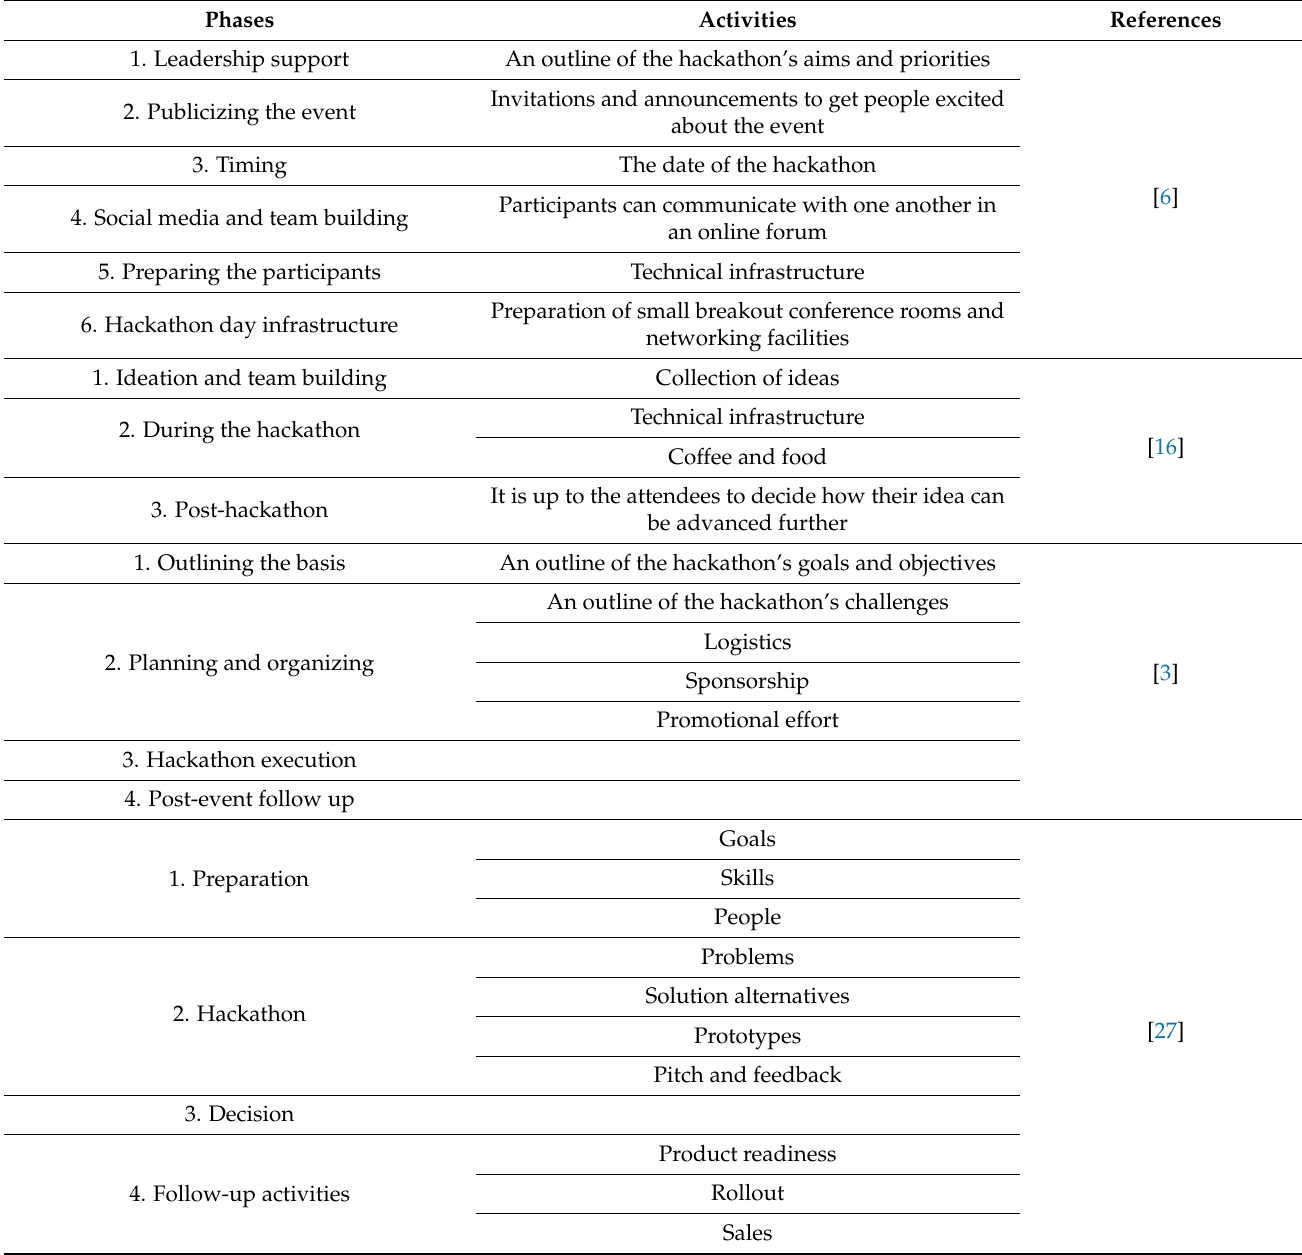
Table 1. Models for organizing